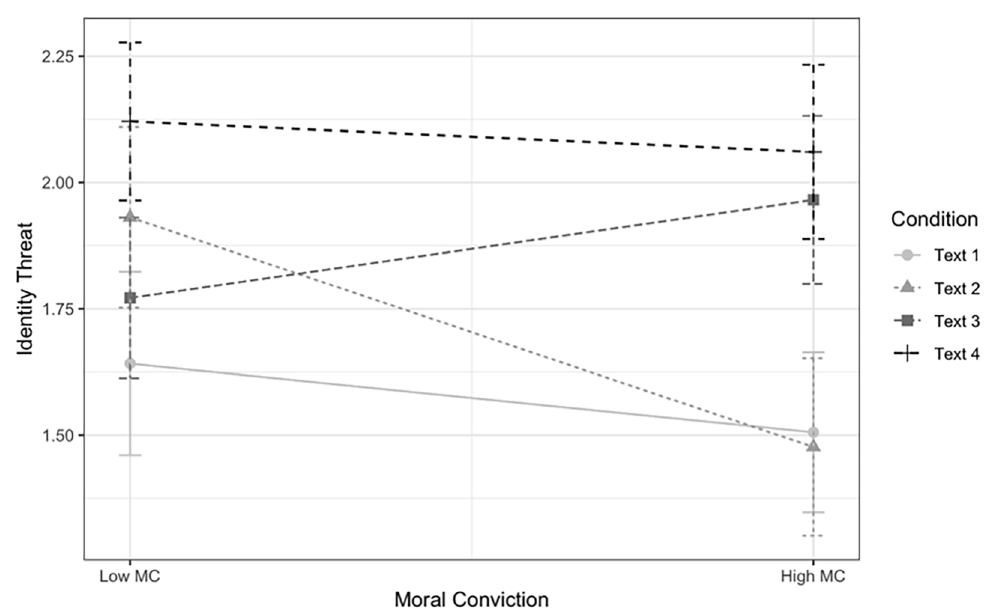
Figure 1. The interactive effect of condition and moral conviction on identity threat. Note. Error bars represent SE s.